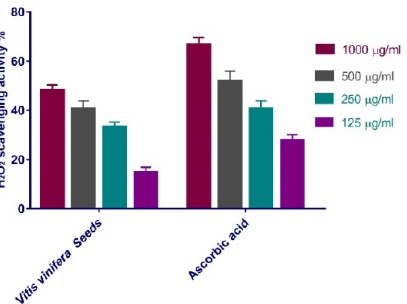
Figure 1. H 2 O 2 radical scavenging activity of V. vinifera seed extract at variant concentrations (1000 µg/mL, 500 µg/mL, 250 µg/mL, and 125 µg/mL). Bars illustrate mean ± standard deviation (SD). Significant difference among groups is analyzed by a two-way ANOVA test.